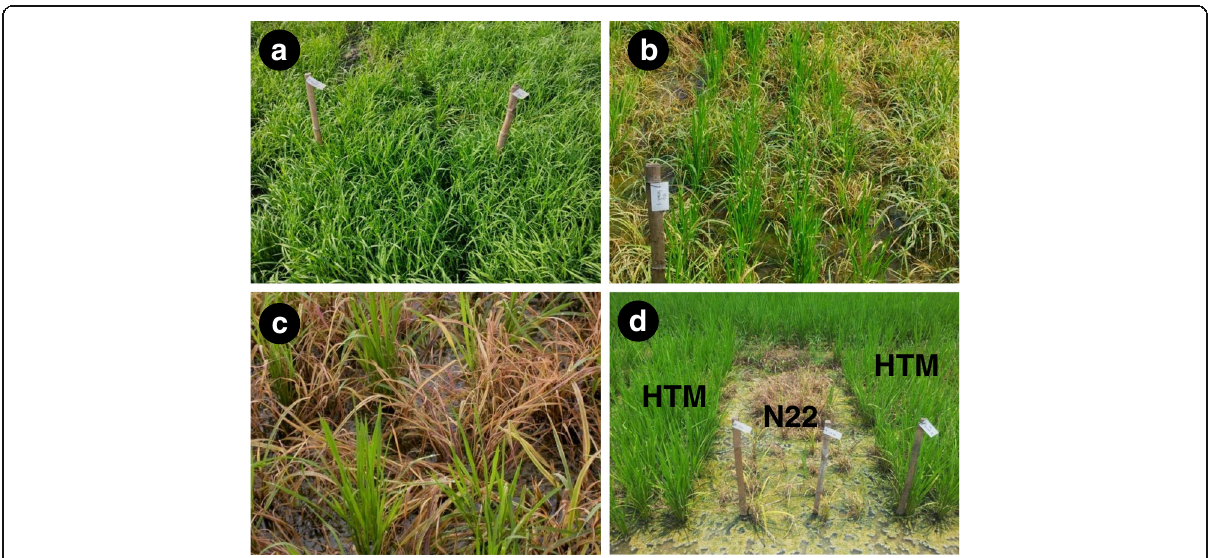
Fig. 2 Mutant progenies 15 days after imazethapyr treatment in M 4 generation. a : HTM-N22 (25th Day after sowing and at the time of treatment); b : HTM-N22 emerging from the weeds 15 days after treatment; c : Efficacy of the weed control (20th day after treatment); d : Nagina 22 killed along with the